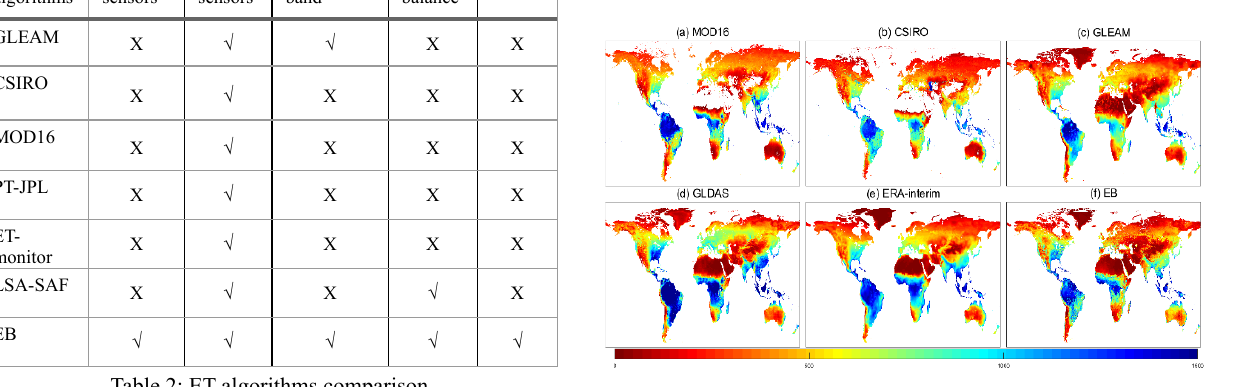
Figure 5 Annual ET from MOD16 (a), CSIRO (b), GLEAM (c), GLDAS (d), ERA-Interim (e) and EB